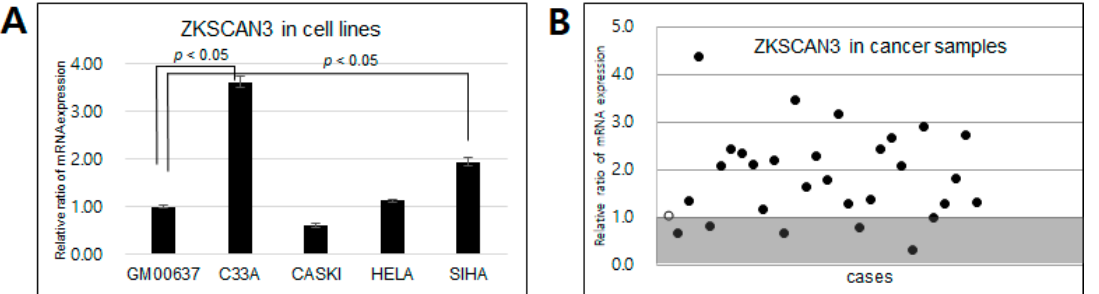
Figure 1. mRNA expression of ZKSCAN3 in cervical cancer cell lines, human fibroblast (GM00637) and tissue samples from patients with cervical cancer. ( A ) qPCR targeting ZKSCAN3 was performed with four cervical cancer cell lines (C33a, Caski, HeLa and SiHa). ( B ) Cervical cancer samples (closed circle) and normal fibroblasts (open circle) were analyzed by qPCR for ZKSCAN3 .